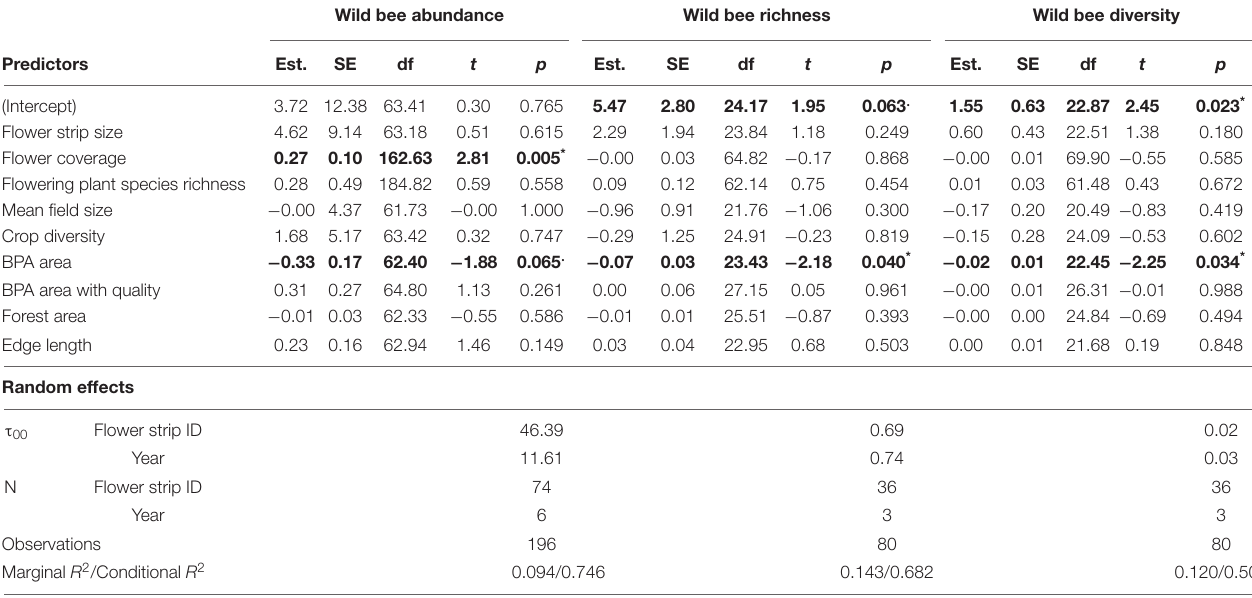
TABLE 4 | Summary of linear mixed-effect models for wild bee abundance, wild bee richness, and wild bee diversity with estimates (Est.), standard errors (SE), degrees of freedom (df), t -values (t), and p -values (*** p < 0.001, ** p < 0.01, * p < 0.05, . p < 0.1) for all fixed effects. Wild bee abundance Wild bee richness Wild bee